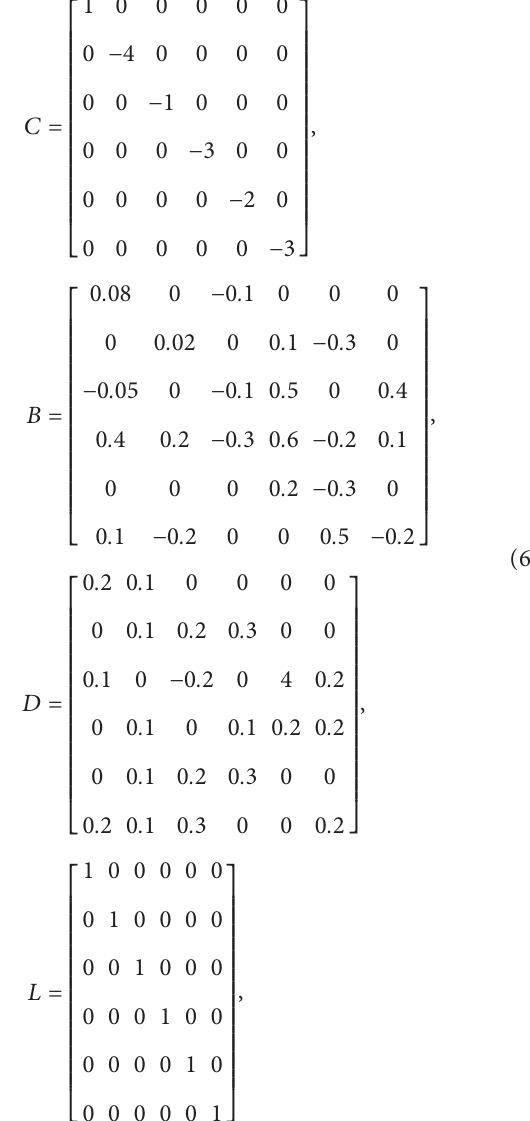
� 0 . 2 ,N � 5 , N � 2, a 0 1